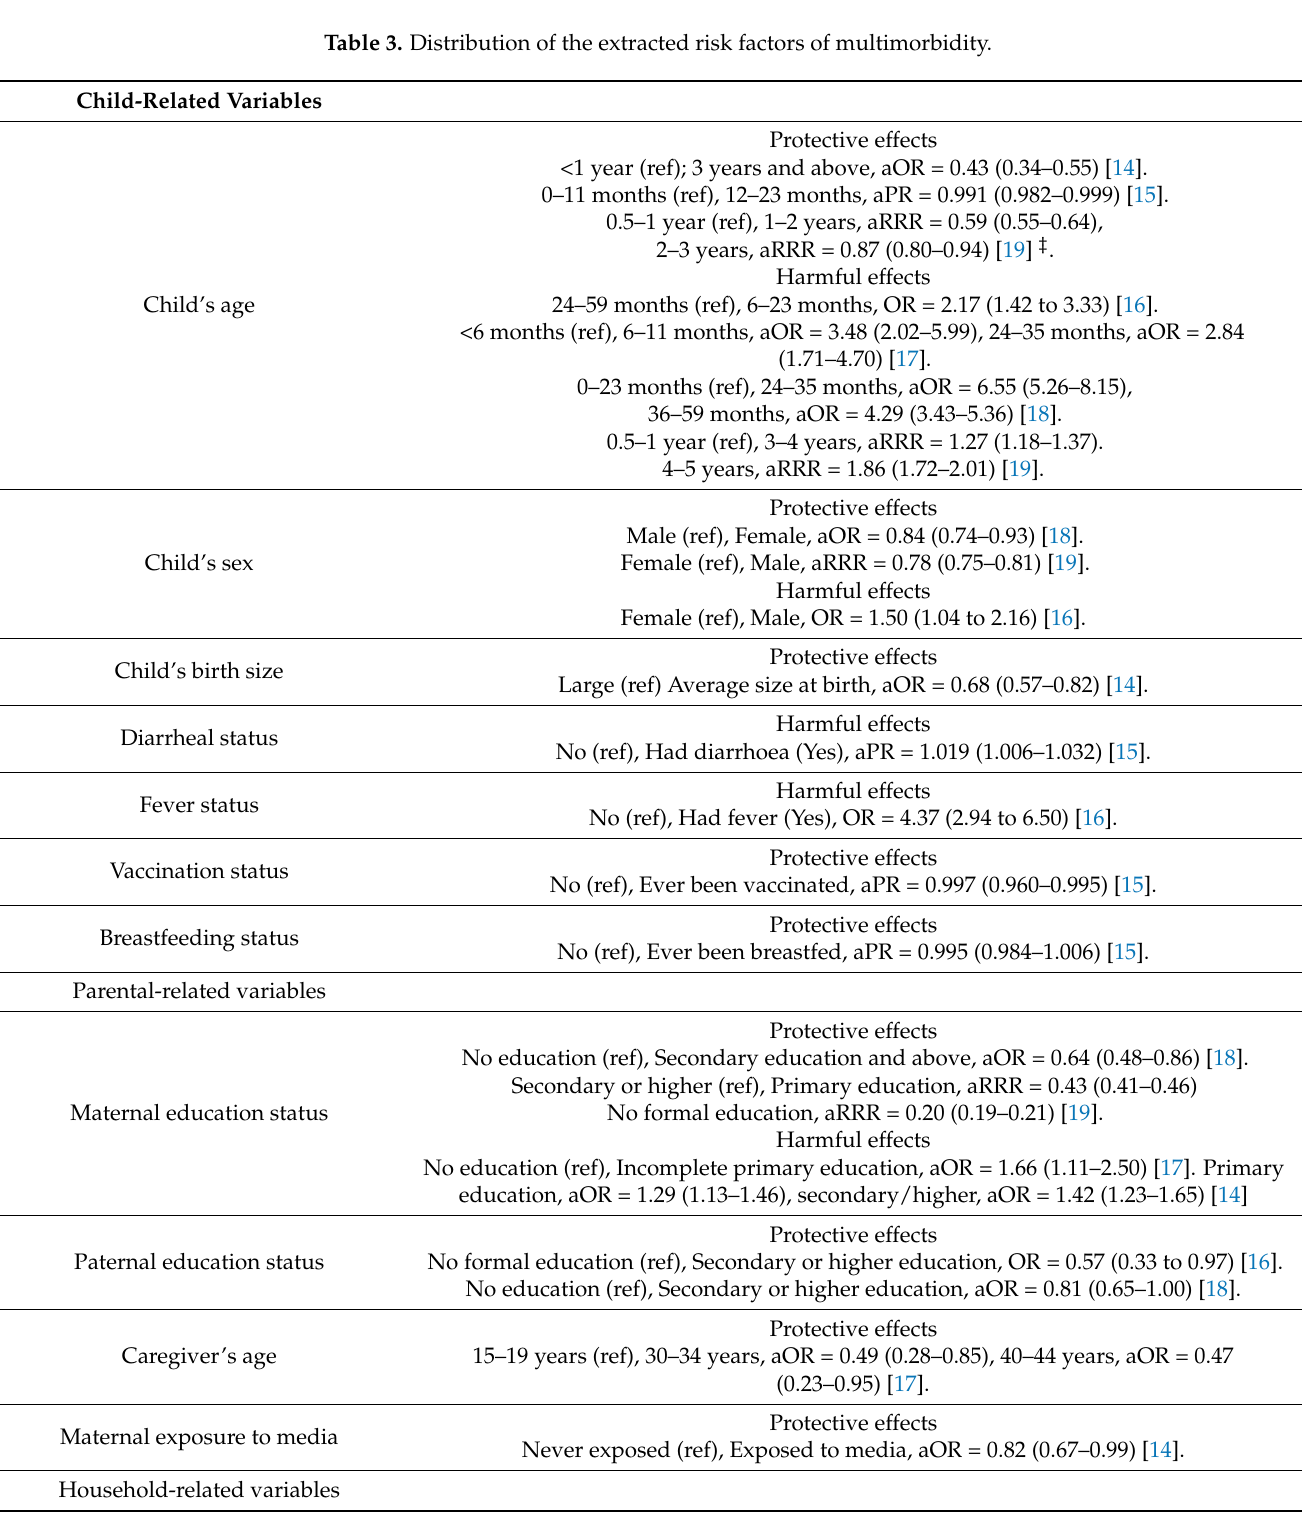
Table 3. Distribution of the extracted risk factors of